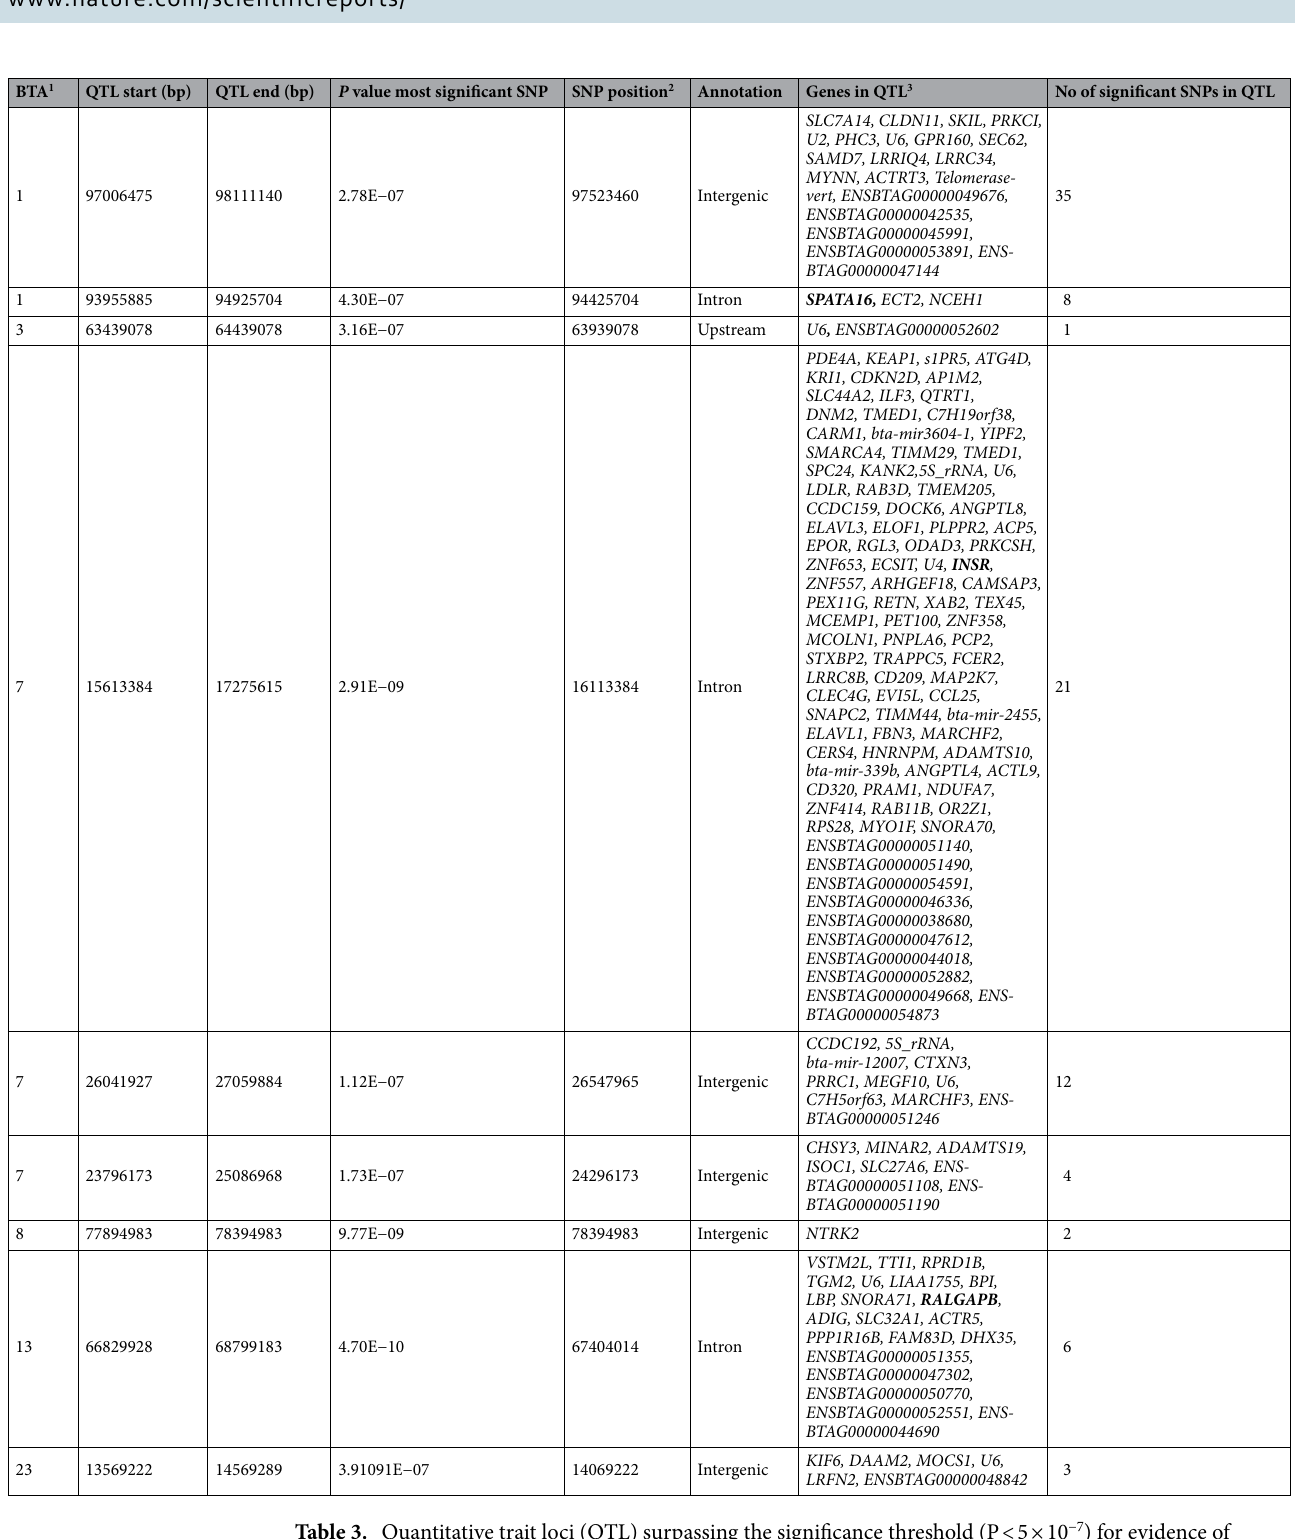
Table 3. Quantitative trait loci (QTL) surpassing the significance threshold (P < 5 × 10 −7 ) for evidence of an association with the diffuse lesions. 1 QTL location, 2 SNP location in the genome assembly, 3 Positional candidate genes are defined as genes that are located within 50 kb on either side of the identified